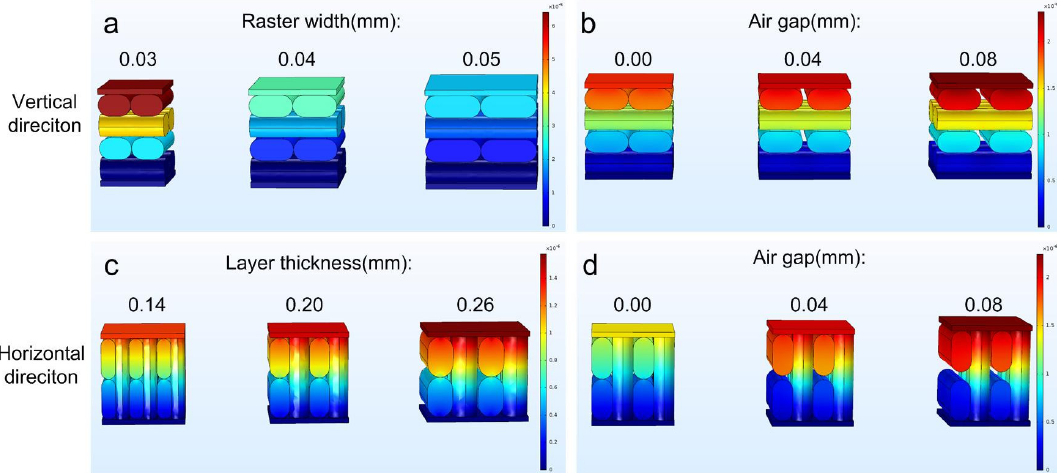
Figure 3. Resistivity of the simulated structure similar to the printed parts as a function of the different process parameters. In the figures, the meaning of the color bars has been illustrated in Figure 1. ( a ) Resistivity in the vertical direction for raster widths of 0.3, 0.4, and 0.5 mm; ( b ) resistivity in the vertical direction for air gaps of 0.00, 0.04, 0.08 mm; ( c ) resistivity in the horizontal direction for layer thicknesses of 0.14, 0.20, and 0.26 mm; and ( d ) resistivity in the horizontal direction for air gaps of 0.00, 0.04, and 0.08 mm.